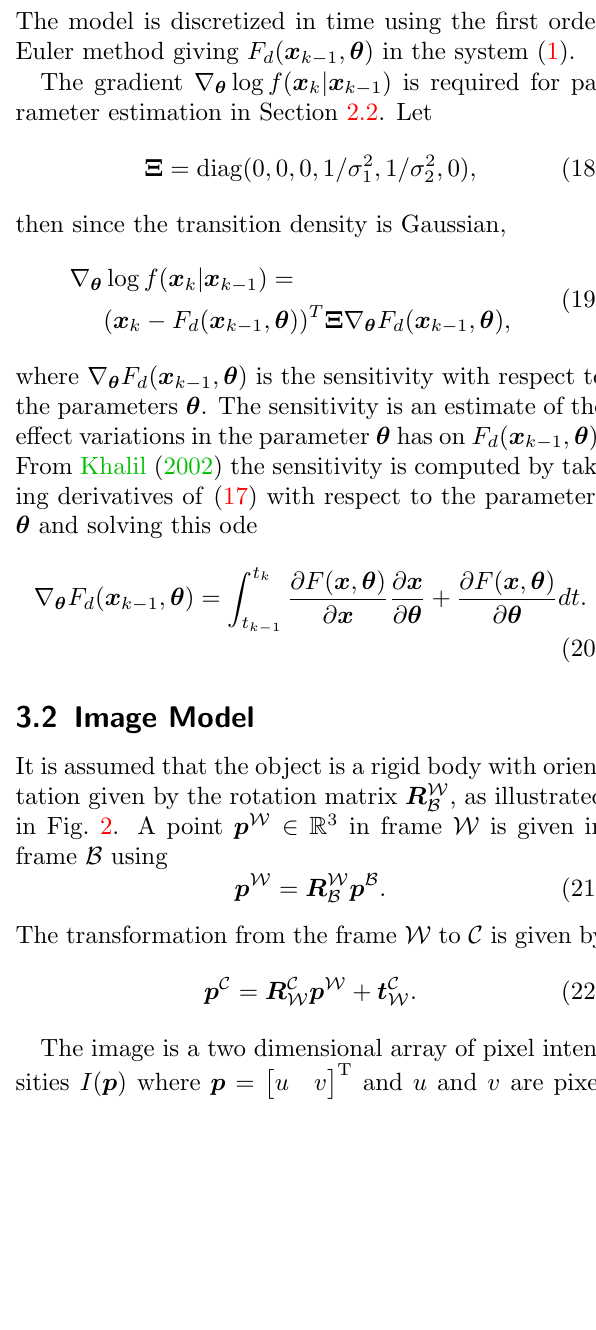
Figure 2: The body reference frame tive to the inertial reference frame geometric trolley model is described by a list of line segments in R 3